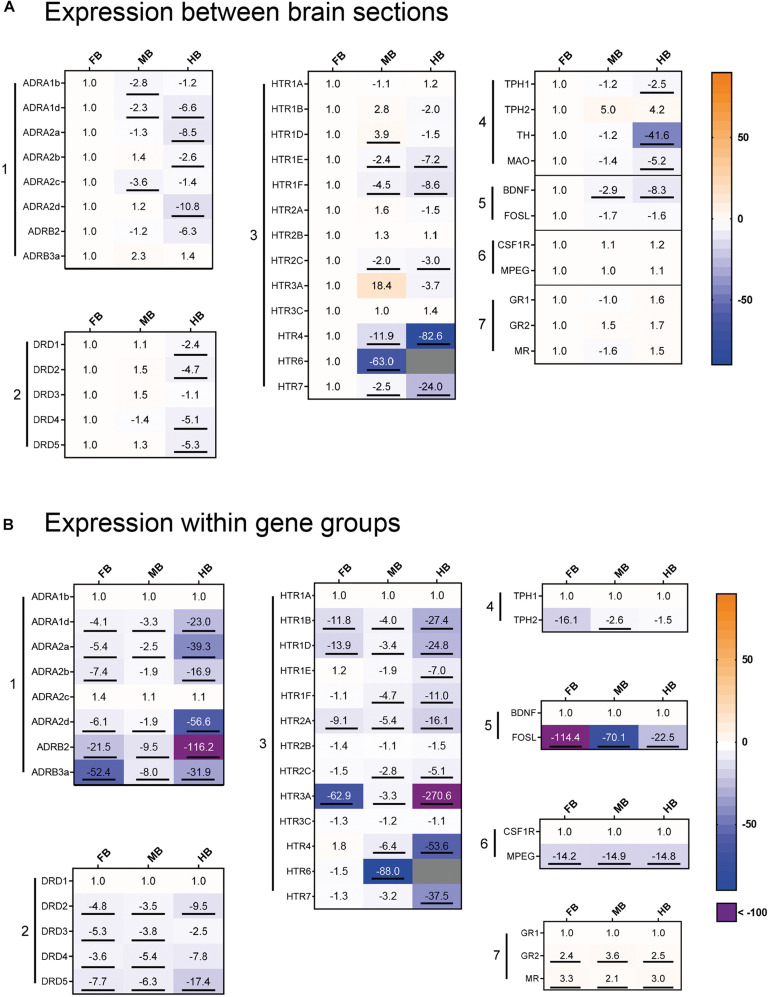
Gene expression profile of maraena whitefish brain. The gene expression was profiled in the control animals of the acute stress experiment (3 and 24 h; n = 12) and analyzed with regard to (A) the different brain sections and (B) to the gene groups expressed. Results are expressed as fold-change values and colored according to the legend on the right. (A) To assess the gene expression in the different sections, the gene-specific transcript numbers in the MB and HB are shown relative to the respective transcript levels in the FB, which were set at 1.0. (B) Within the gene groups, the transcript numbers of the different genes are shown relative to the respective transcript levels of the gene in the first row, which were set at 1.0. The gene groups comprised (1) adrenergic receptor genes; (2) dopamine receptor genes; (3) 5-HT receptor genes; (4) monoamine synthesis genes; (5) neuronal activity markers; (6) microglia cell markers; (7) cortisol receptor genes. Genes were considered significantly regulated (marked by an underline) in the event of at least a twofold up or down-regulation of the transcript concentration and a p-value < 0.05 (Student’s t-test).